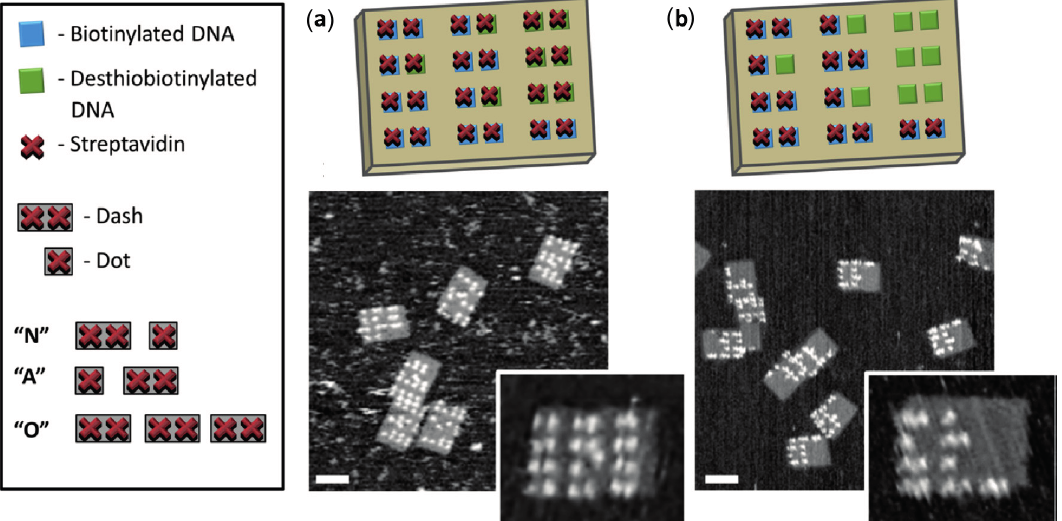
Figure 7. Design of the SAv Morse code arrangement on DNA origami substrates with corresponding code translation. After SAv binding, the DNA origami display the Morse code for “OOOO” ( a ). After addition of free Bt, the selective release of SAv from the origami results in the message “NANO” ( b ). Reprinted with permission from Ref. [41]. Copyright 2013 American Chemical